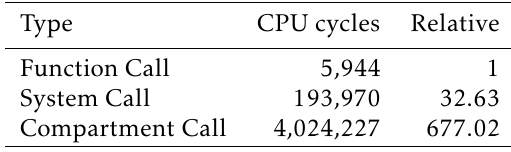
Table 2. Compartment access overhead